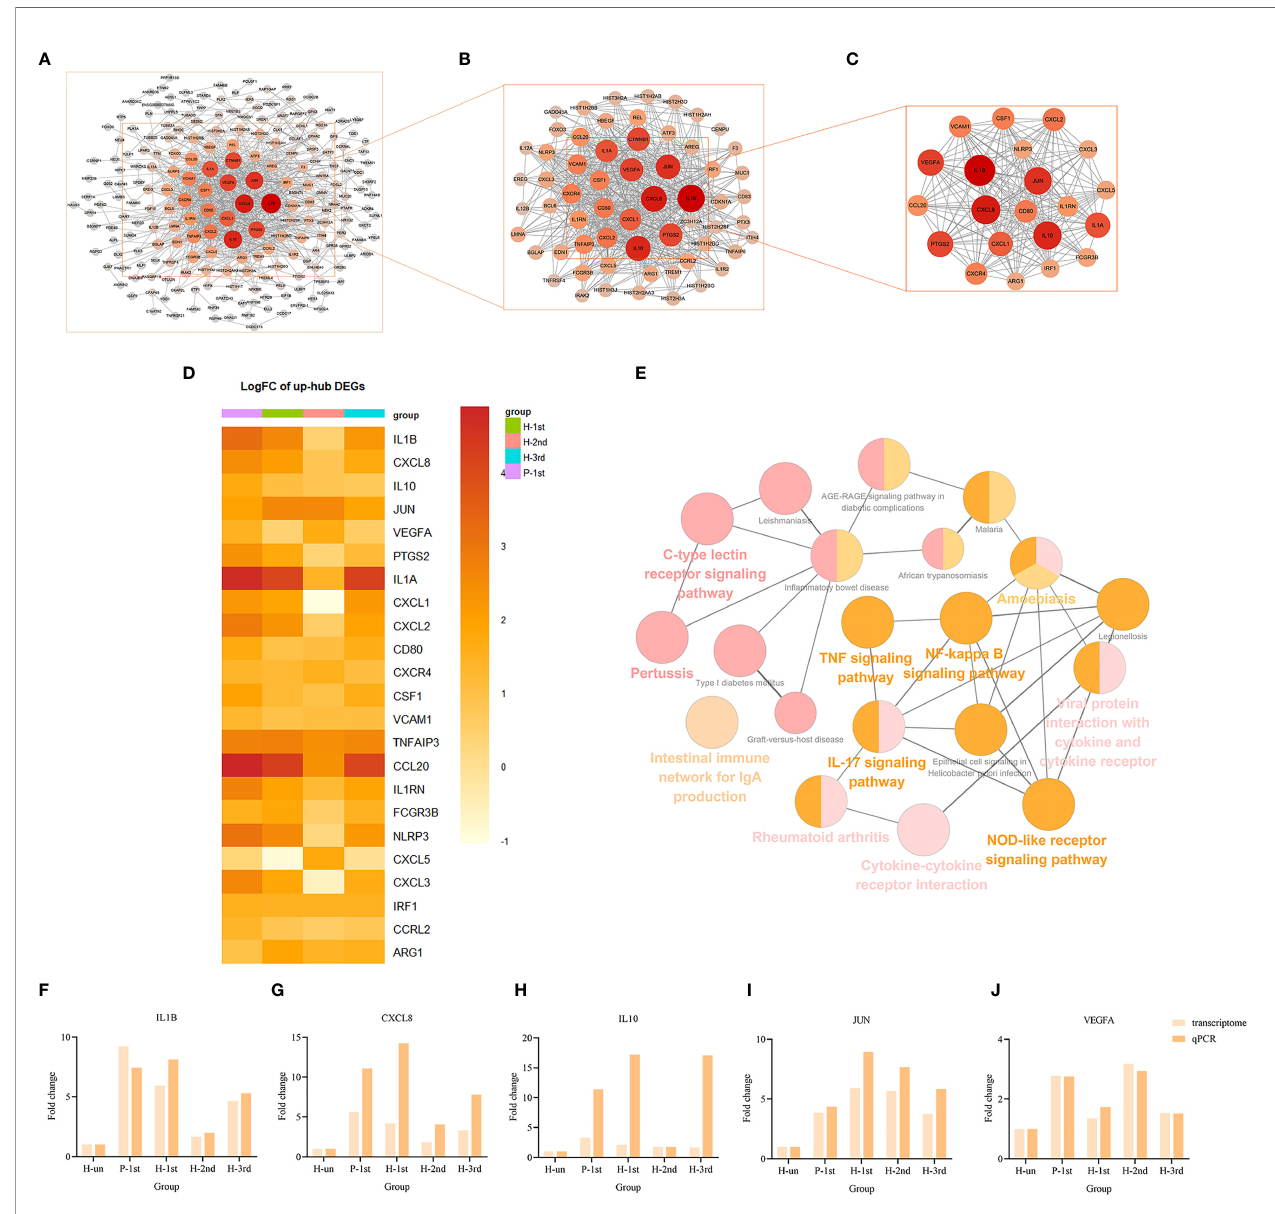
FIGURE 4 | PPI networks of the up-regulated DEGs in vaccination groups. (A) The PPI network of all up-regulated DEGs, consisting of 304 nodes. (B) PPI network extracted from A by Degree Centrality, consisting of 61 nodes. (C) The PPI network extracted from B by MCODE, consisting of 32 nodes. PPI, protein-protein interaction; DEGs, differentially expressed genes. (D) The differential expression of 23 characteristic up-regulated DEGs in the four vaccination groups. Each row represents mRNA and each column represents a group. (E) A total of 35 KEGG pathways of the 23 characteristic up-regulated DEGs. (F – J) Expression levels of IL1B, CXCL8, IL10, JUN and